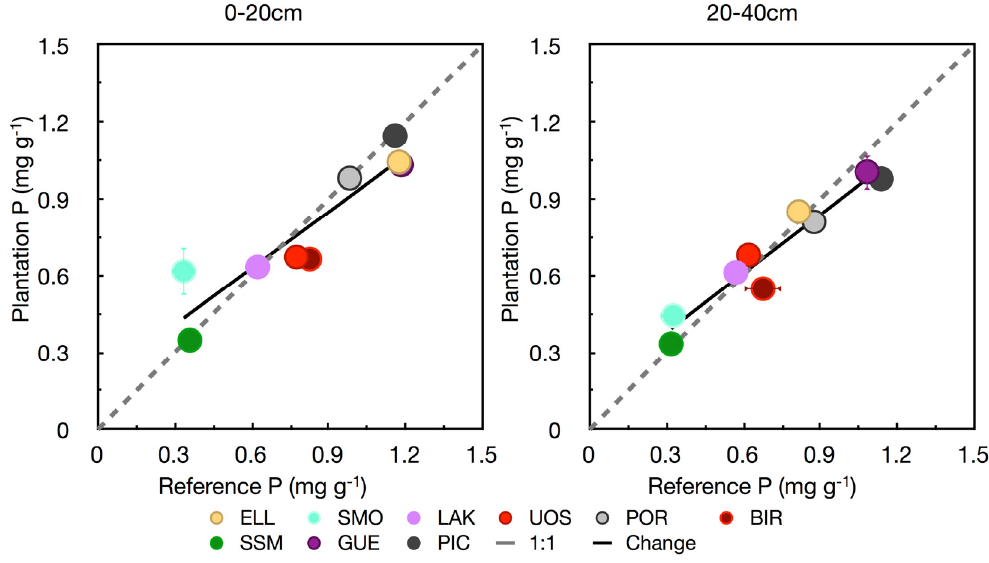
Figure 3. Initial concentration of acid leachable P, as estimated from reference sites, versus acid leachable P concentration in plantations after the first rotation of nine S. purpurea “Hotel” plantations (ELL, SMO, LAK, UOS, POR, BIR, SSM, GUE, and PIC). Error bars represent standard error when greater than symbol